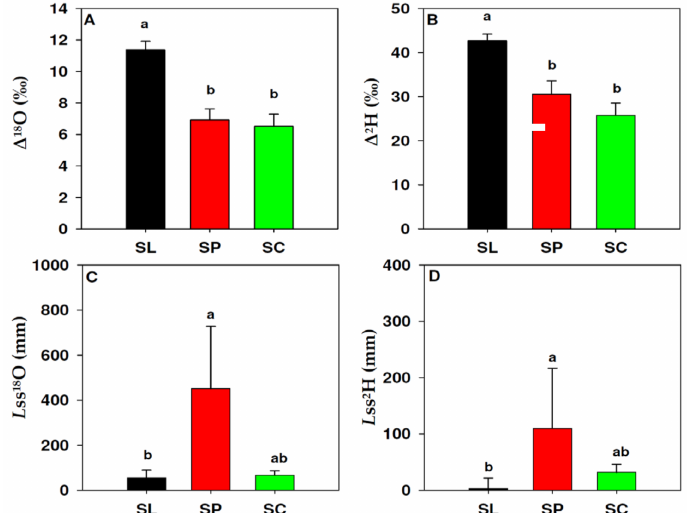
Figure 3. Leaf water enrichment traits in S. lycopersicum (black, SL), S. peruvianum (red, SP) and S. chilense (green, SC). ∆ 18 O and ∆ 2 H, oxygen ( A ) and hydrogen ( B ) leaf water isotopic enrichment; L ss18 O and L ss 2 H, effective path length, calculated from ∆ 18 O and ∆ 2 H. Values in ( A , B ) represent the mean and standard error. Values in ( C , D ) represent the median and 75% percentile. Letters indicate significant differences ( p < 0.05) according to Fisher ( A , B ) and Dunn’s ( C , D )